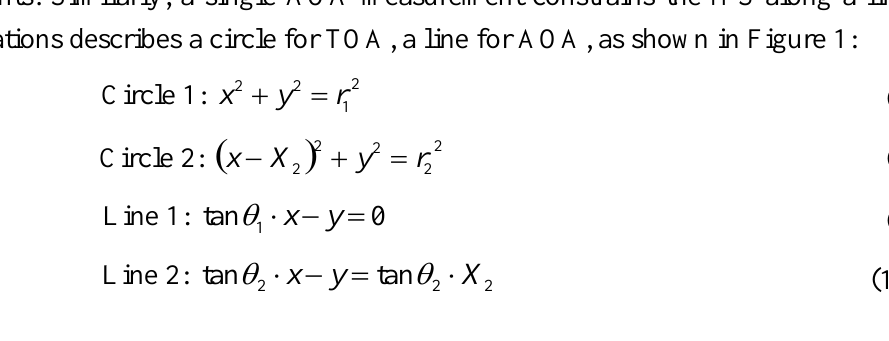
Figure 1. Geometric layout of the two circles and two